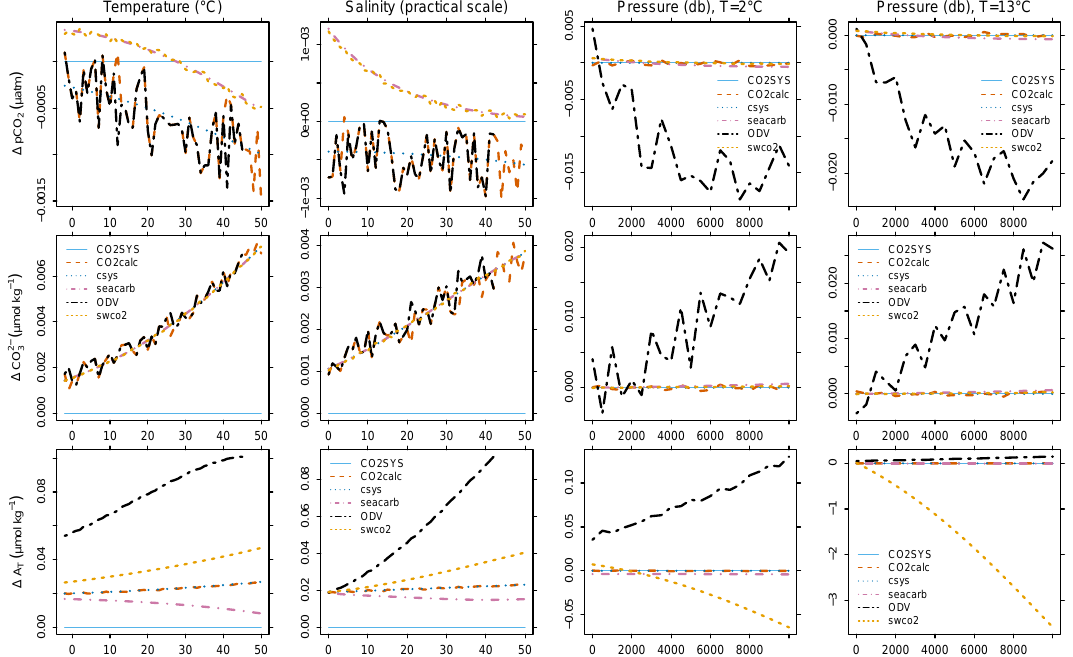
Figure 8. Variables computed from C T and pH with each package minus corresponding results from CO2SYS-MATLAB. Shown are com- puted p CO 2 (top), CO 2 − (middle), and A T (bottom) across ranges of T (column 1), S (column 2), and P when T = 2 ◦ C (column 3) and 3 when T = 13 ◦ C (column 4) for each software